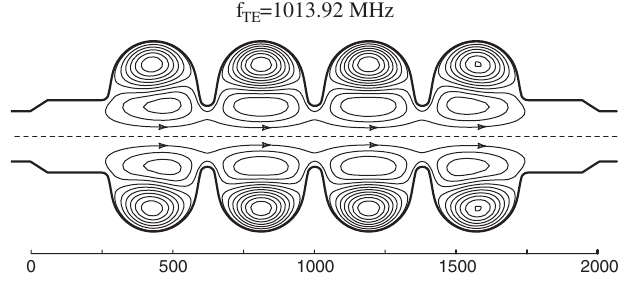
FIG. 6. Magnetic field pattern of the focusing mode TE 021 (0- type). have selected the 1013.9 MHz TE 021 0-type mode. For this mode, the ratio of the peak magnetic field at the surface ( B peak ) to the maximum field on axis ( B TE ) is relatively small: B peak =B TE ¼ 0 : 46 . Figure 6 shows the magnetic rf field pattern of this TE mode in the cavity.